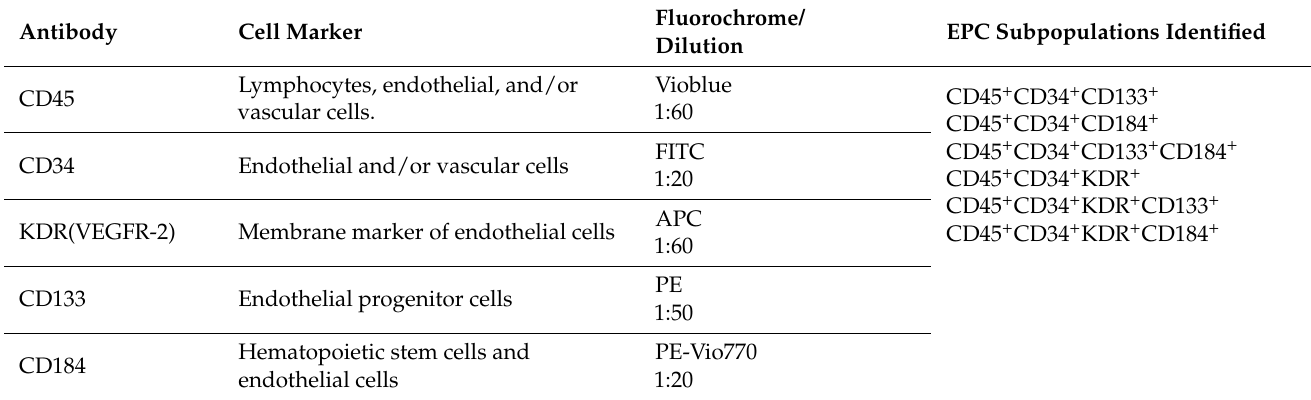
Table 1. Antibodies used for flow